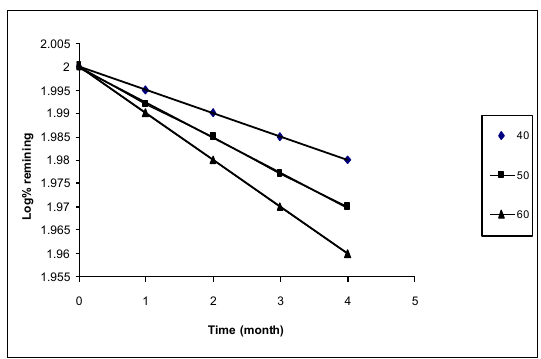
Figure (3): Degradation curve of frusemide elixir (formula III) at 40, 50, 60 0 C